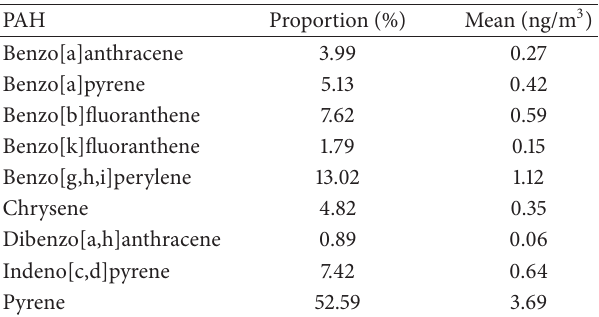
Table 1: Components of PAH